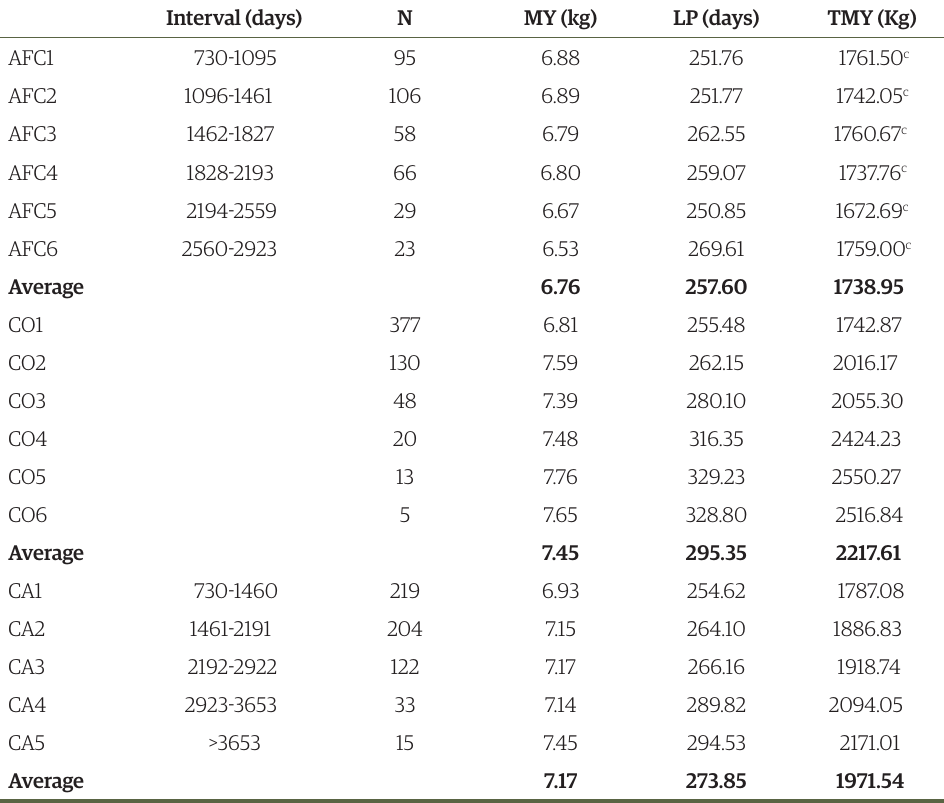
Table 2. Averages for milk yield (MY), lactation period (LP) and total milk yield (TMY) according to classes